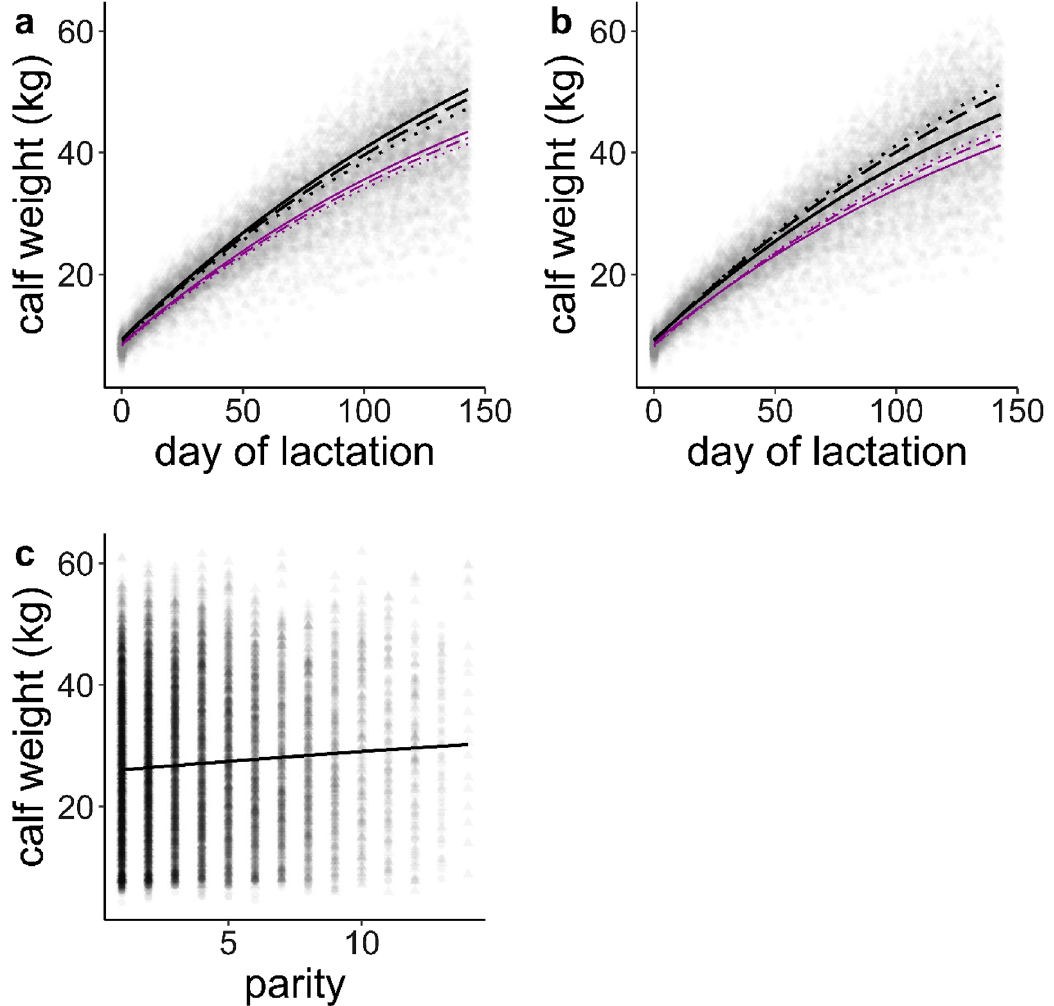
Figure 1. Prediction of male and female red deer calf weight against day of lactation contingent upon hind weight ( a ), hind age ( b ) and parity ( c ). Predictions are based on the model in Supplementary Information 3 Table 1 after fixing the main effects at their mean values and hind weight and hind age at their quartiles Q1, Q2 and Q3. ( a ) thin-magenta line: female calf; thick-black line: male calf; dotted, dashed and solid lines are 90 kg (Q1), 98 kg (Q2) and 107 kg (Q3) hinds body weight, respectively. ( b ) thin-magenta line: female calf; thick-black line: male calf; dotted, dashed and solid lines are hinds at age 3 years (Q1), 5 years (Q2) and 8 years (Q3) old. Triangle: male; circle: